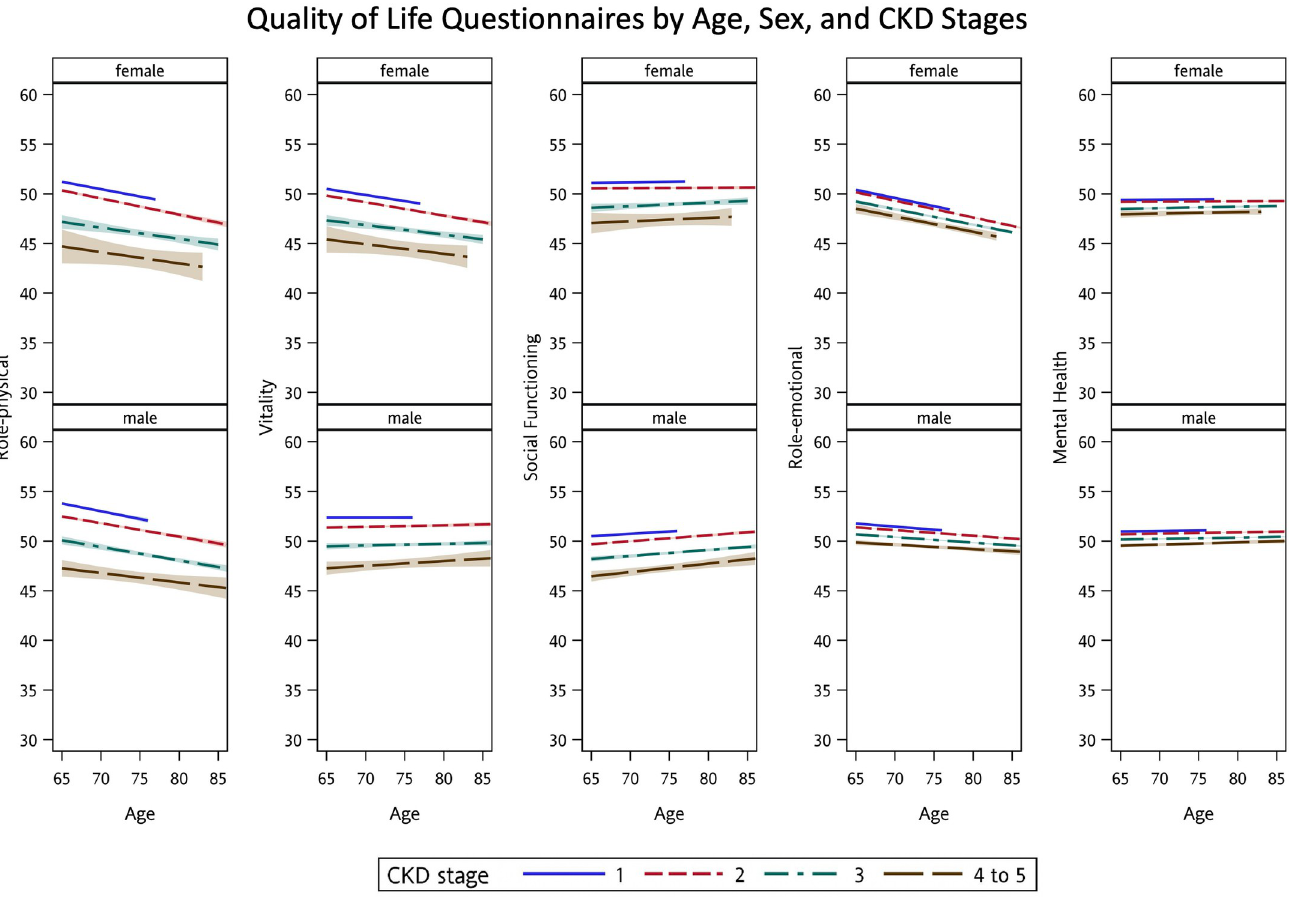
Fig 3. Quality of life questionnaires by age, sex, and chronic kidney disease (CKD) stages.